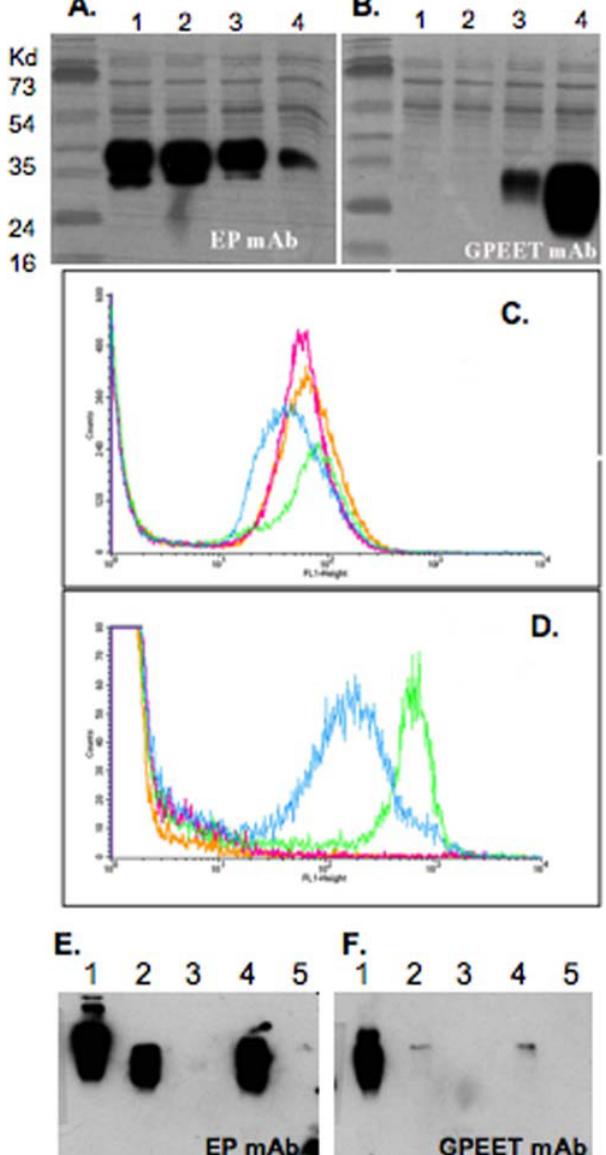
Figure 2. Immunoblot and flow cytometric analysis of procy- clins expressed in YTat1.1 WT and YTat 1.1 EP procyclic culture forms. (A and B) Detection of EP procyclins with mAb 247 and GPEET procyclin with mAb 5H3, respectively. Lane 1: YTat 1.1 EP PCF (July 2003), Lane 2: YTat 1.1 EP PCF (Sept 2003), Lane 3: YTat1.1 WT PCF, Lane 4: T. b. brucei 427.01 WT PCF (positive control). Molecular weight markers are shown on the left. The autoluminograms are shown overlayed onto nigrosin stained membranes to show protein loadings. (C) Surface expression of EP on living PCF trypanosomes detected with mAb 247. (D) Surface expression of GPEET on living PCF trypanosomes detected with mAb 5H3. Blue lines: YTat 1.1 WT (Sept 2002), Green lines: YTat 1.1 WT (July 2004), Orange lines: YTat 1.1 EP (July 2003), Red lines: YTat 1.1 EP (Sept 2003). (E and F) Detection of EP and GPEET procyclins from (Lane 1) in vitro YTat1.1 WT , (Lane 2) YTat1.1 WT obtained from midguts 12-days post infection acquisition, (Lane 3) YTat1.1 WT obtained from proven- triculus 12-days post infection acquisition, (Lane 4) YTat1.1 EP obtained from midgut 12-days post infection acquisition and (Lane 5) YTat1.1 EP obtained from proventriculus 12-days post infection acquisition.